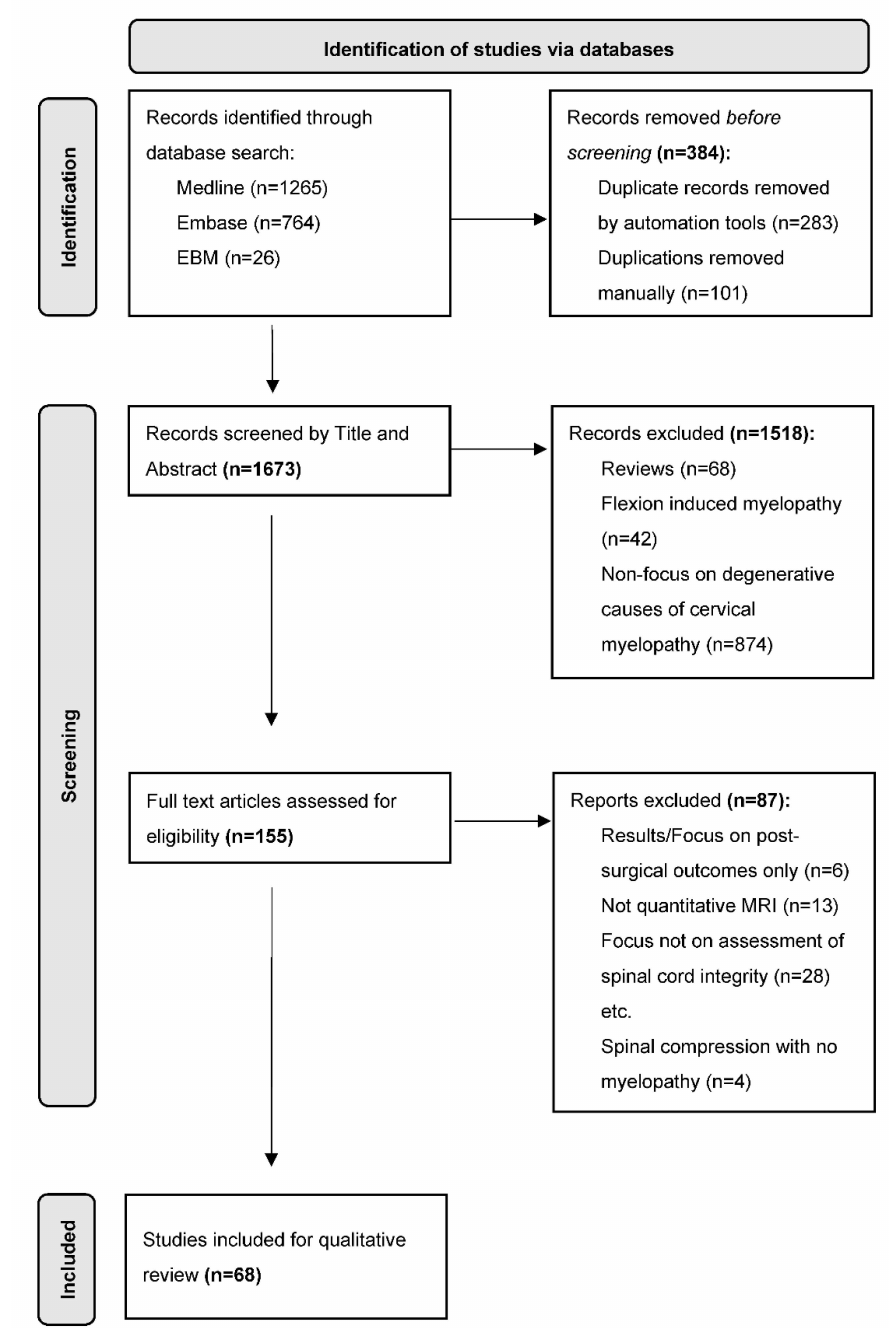
Figure 3. Literature Search Flowchart (See Appendix B—Figure A1. for database search strat- egy). Adapted from PRISMA Scoping Review protocol [121]. Abbreviations: MRI, magnetic reso- nance